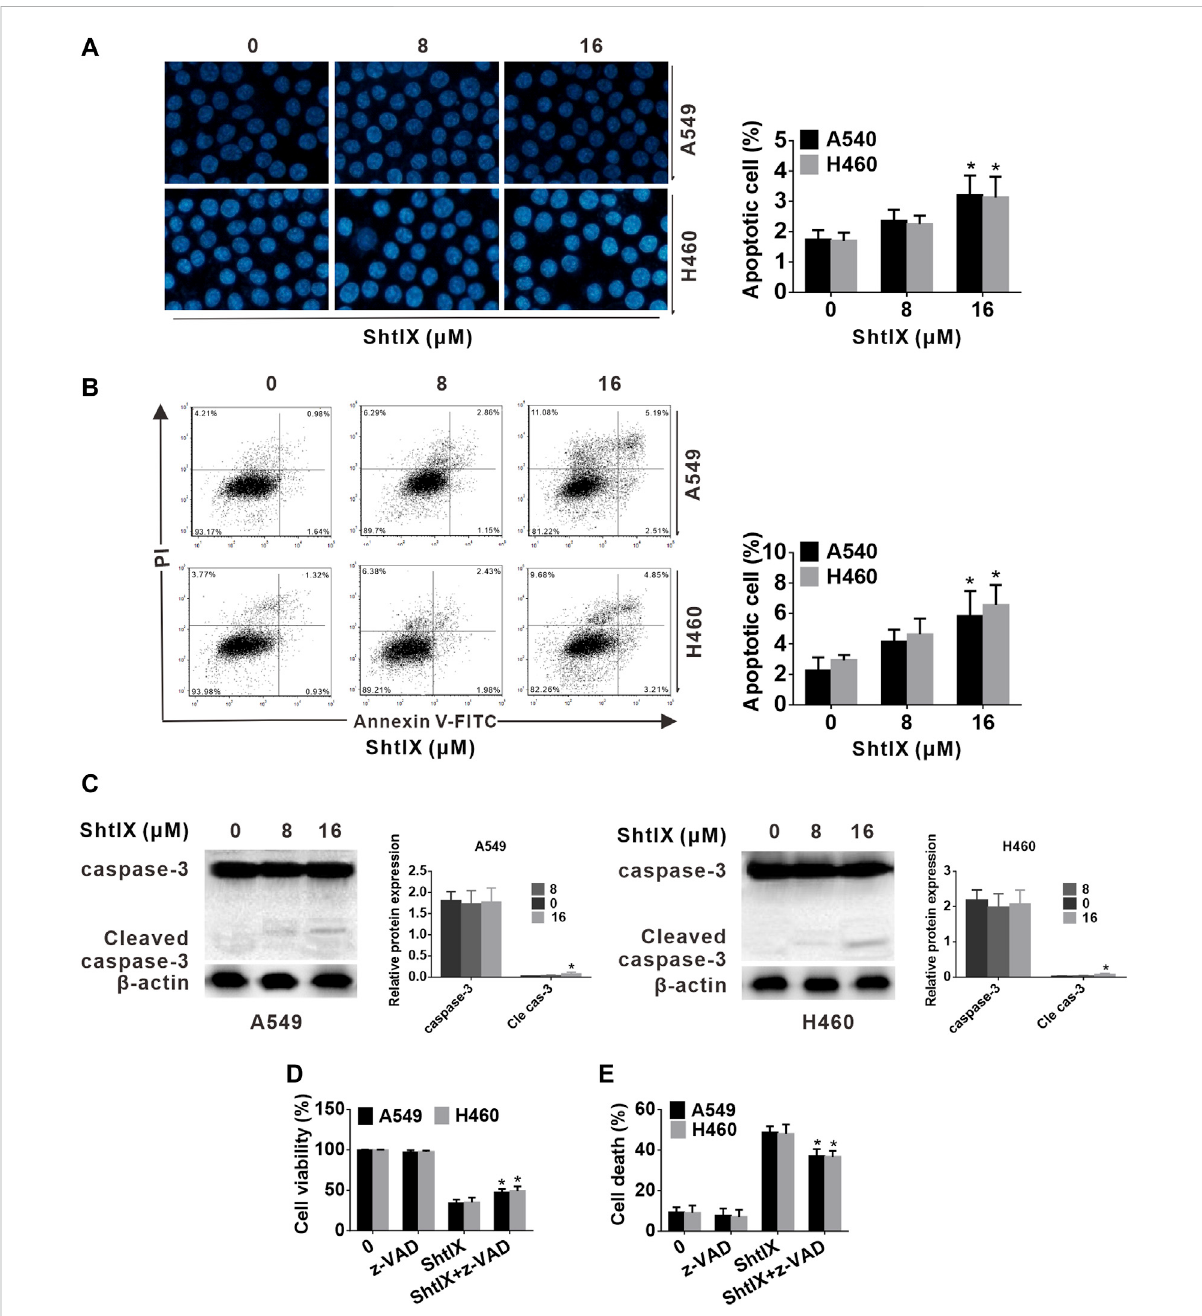
FIGURE 3 The apoptotic events of ShtIX-induced were observed. Cells were treated with the given dose of ShtIX for 24 h (A) NSCLC cells morphological change was observed by Hoechst 33,258 staining. (B) Early and late apoptotic cells induced by ShtIX were detected by Annexin V-FITC/PI. (C) The apoptotic related-proteins were analyzed by western blot. (D) Cells were treated with ShtIX in combination with or without Z-VDA-FMK, the cell viability was detected using CCK-8 assays. (E) Cells were treated as in D, the cell death weredetected by LDH release assay. Data are expressed as mean ± SD of triplicate experiment. * p < 0.05, ** p <